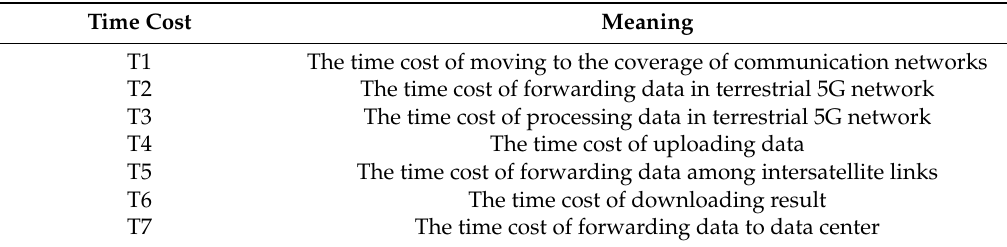
Figure 4. Experimental simulation scenario. Table 2. The meaning of each time cost.